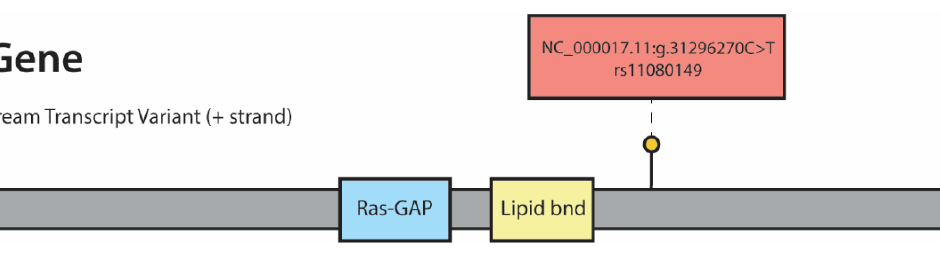
Figure 3. Location of NF1 germline variant. One intronic germline variant, NC_000017.11:g.31296270C > T (rs11080149). was identified and is depicted in this figure.